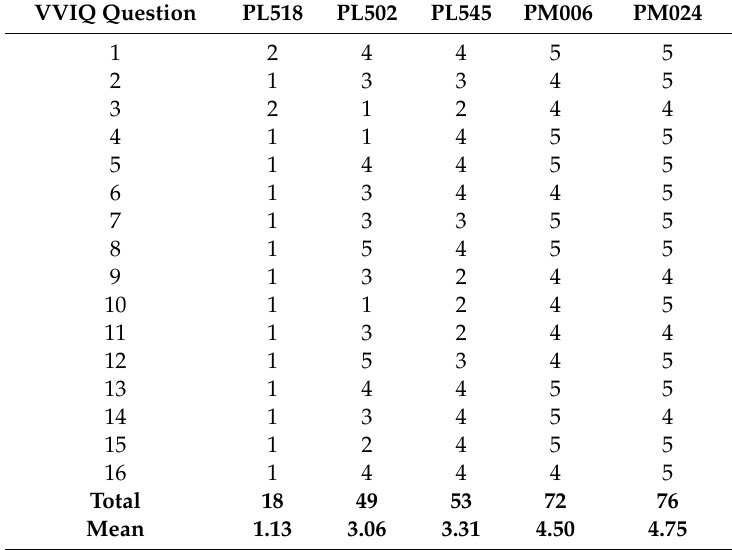
Table A1. Individual responses on the Vividness of Imagery Questionnaire (VVIQ)-modified [39]. Total and mean scores in